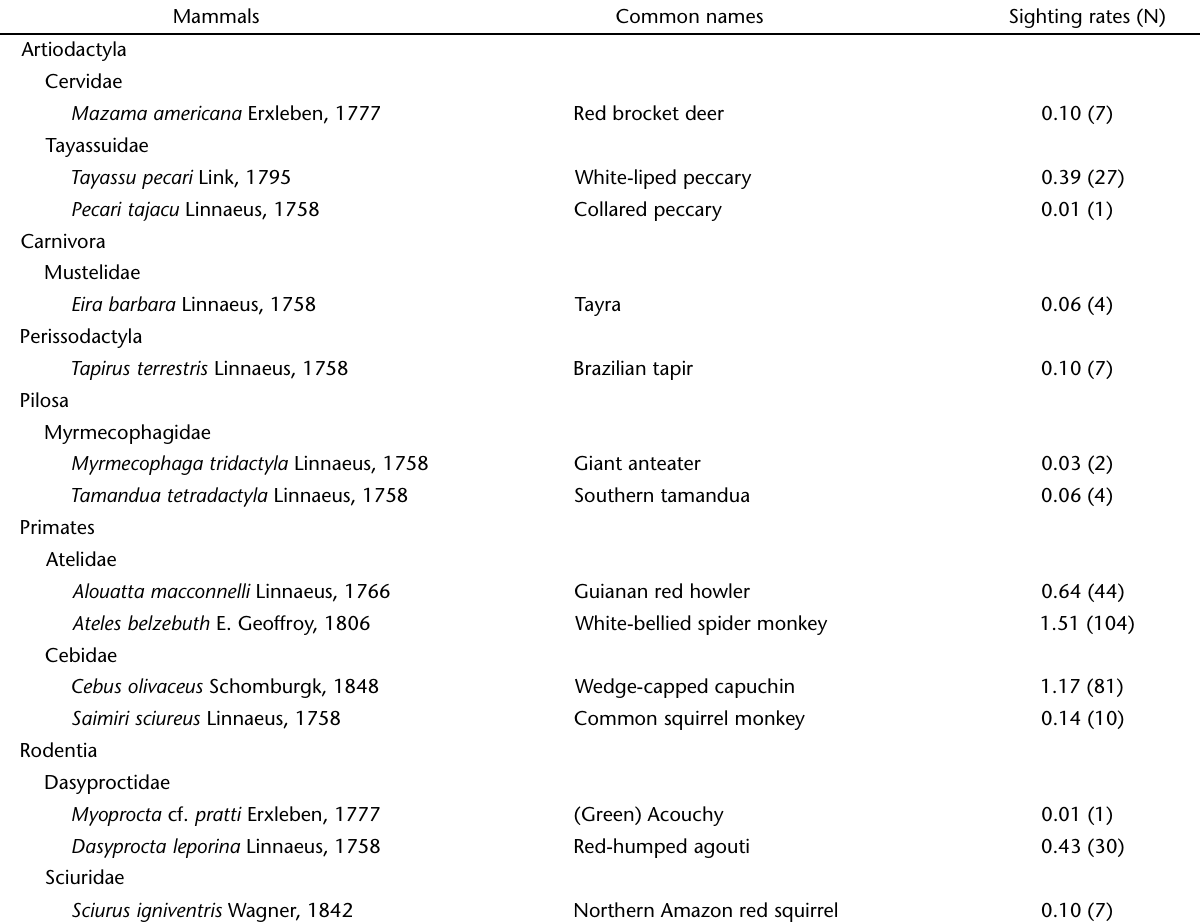
Table II. Abundances of the mid- to large-sized mammals recorded during linetransect surveys at Maracá Ecological Station, Roraima, Brazil. Sighting rates were calculated as the number of sightings per 10 km walked, based on 690 km surveyed.